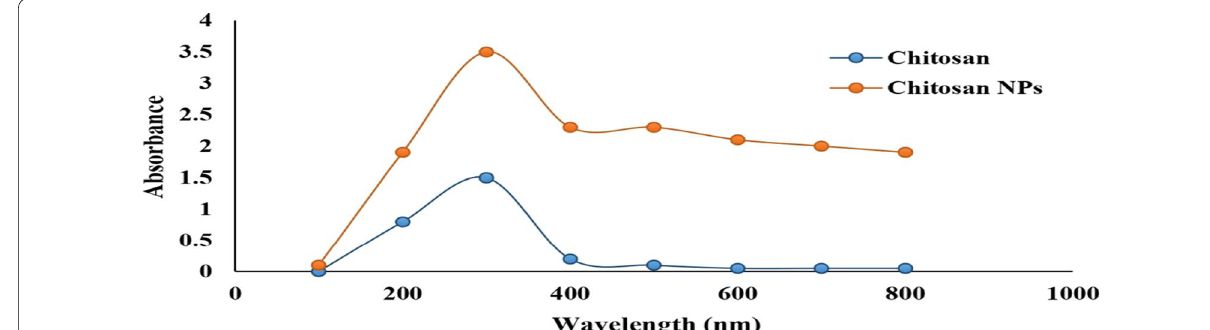
Fig. 2 UV–visible spectra of chitosan and CNPs